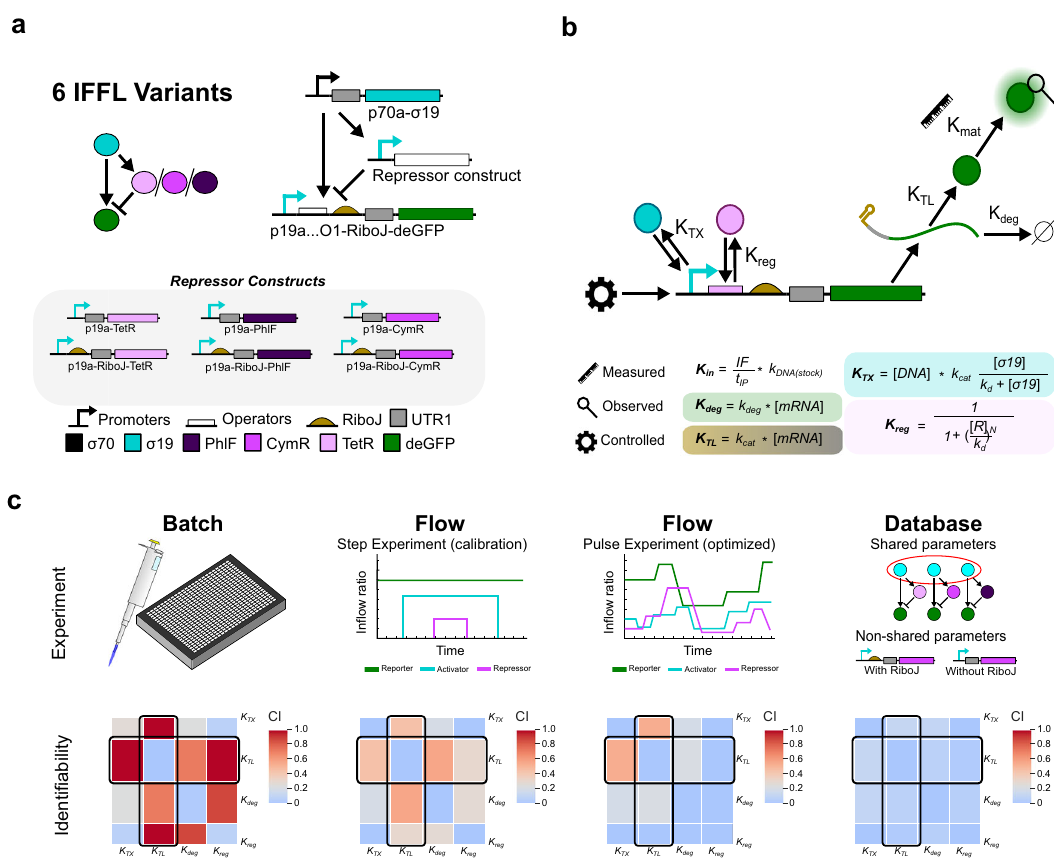
Fig. 2 Design of the IFFL networks, model and in silico analysis of parameter identi fi ability. a IFFL variants considered in this study. We used 3 repressor constructs, each of which has a version which includes/excludes a RiboJ sequence. The reporter constructs bear a single operator site for the corresponding repressor downstream of the transcriptional start site. b Model describing the CFPS process of a gene. Maturation rates of deGFP and mmCherry are known. Concentrations of the genetic construct over time are controlled, a single protein reporter is observed. All parameters are lumped into four categories ( K TX , K TL , K reg and K deg ), general expressions for all four are provided. c An identi fi ability analysis based on Gábor et al. 33 . The inverse of smallest eigenvalue from the single value decomposition analysis is taken, called the collinearity index, this corresponds to the degree of covariance between parameters for the simulations. Covariance between parameters reduces from batch to fl ow, step fl ow to optimized fl ow and is lowest when all simulations (i.e. whole database) are included in the fi tting process. The parameters shared between experiments in the fi nal dataset become a point of information as the difference in expression rates can solely be attributed to non-overlapping parameters such as an identical experiment with and without a RiboJ sequence in the construct. The pairwise collinearities between K TL and all other parameters are highlighted by the black